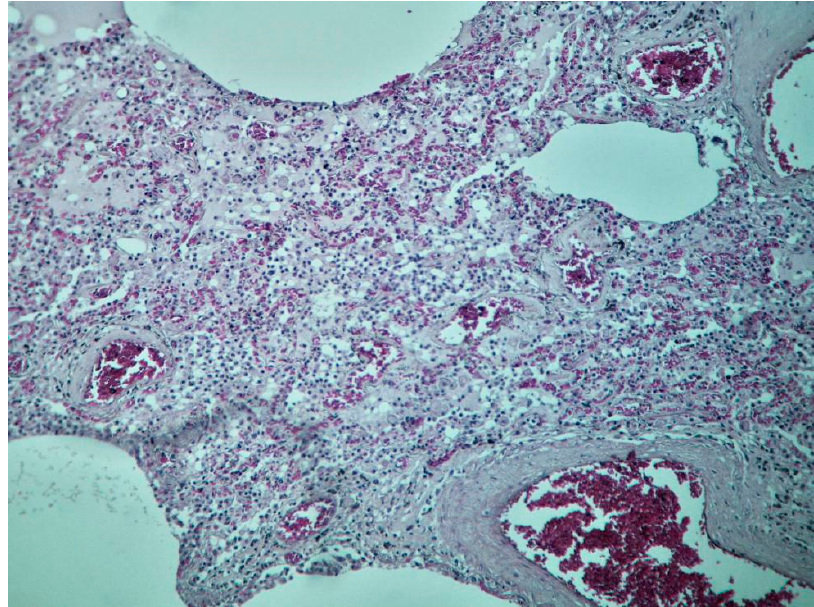
Figure 9. Tissue sample from the left lung parenchyma, from the perihilar region, fixed in a 10% formaldehyde solution with neutral Ph for a minimum of 72 h. Diagnosis: hematoxylin–eosin (HE)-staining (200 × magnification), lung parenchyma showing alveolar spaces filled with a pale-eosinophilic, finely granular content (transudate; alveolar oedema), neutrophils and scattered macrophages, and vascular congestion within alveolar walls (mixed inflammatory cell infiltration in the alveoli).